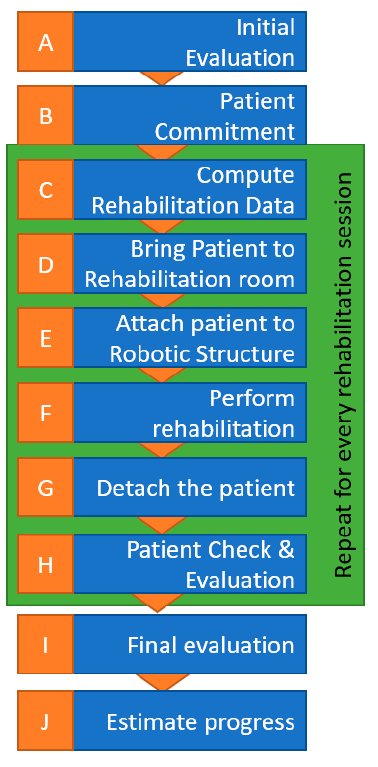
Figure 8. Medical rehabilitation protocol flow chart.